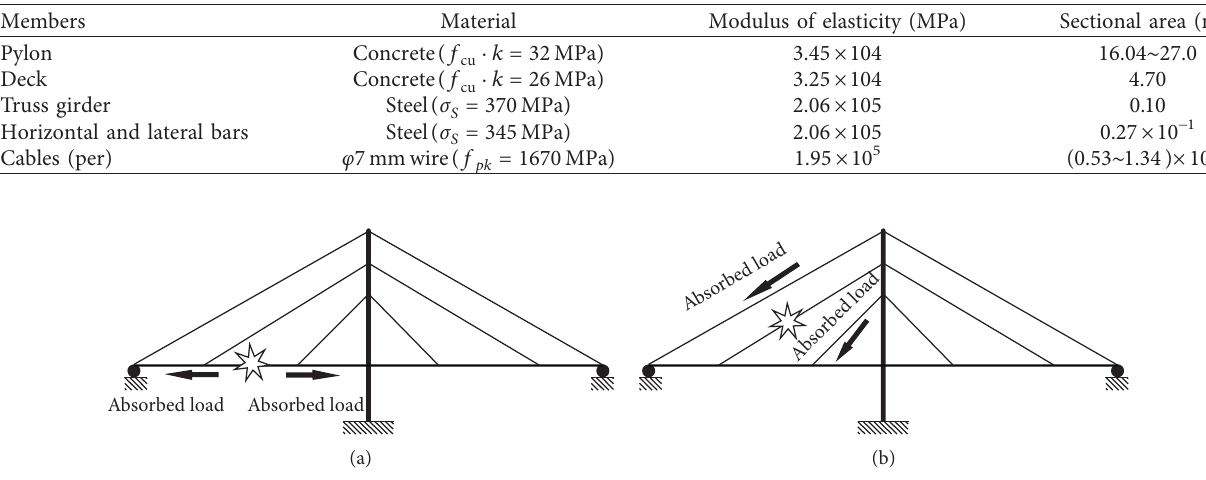
Figure 4: Failures of individual members of the cable-stayed bridge: (a) load transfer after girder failure; (b) load transfer after cable failure.